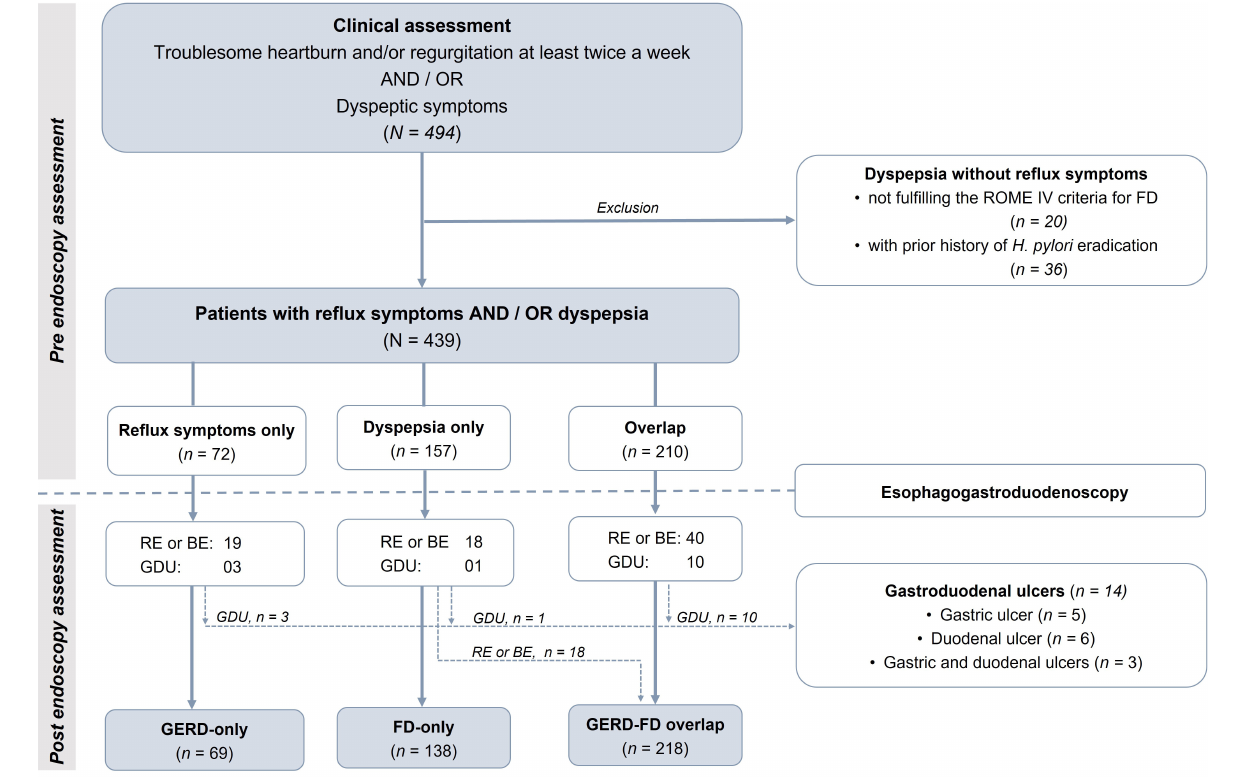
Frontiers in Medicine |